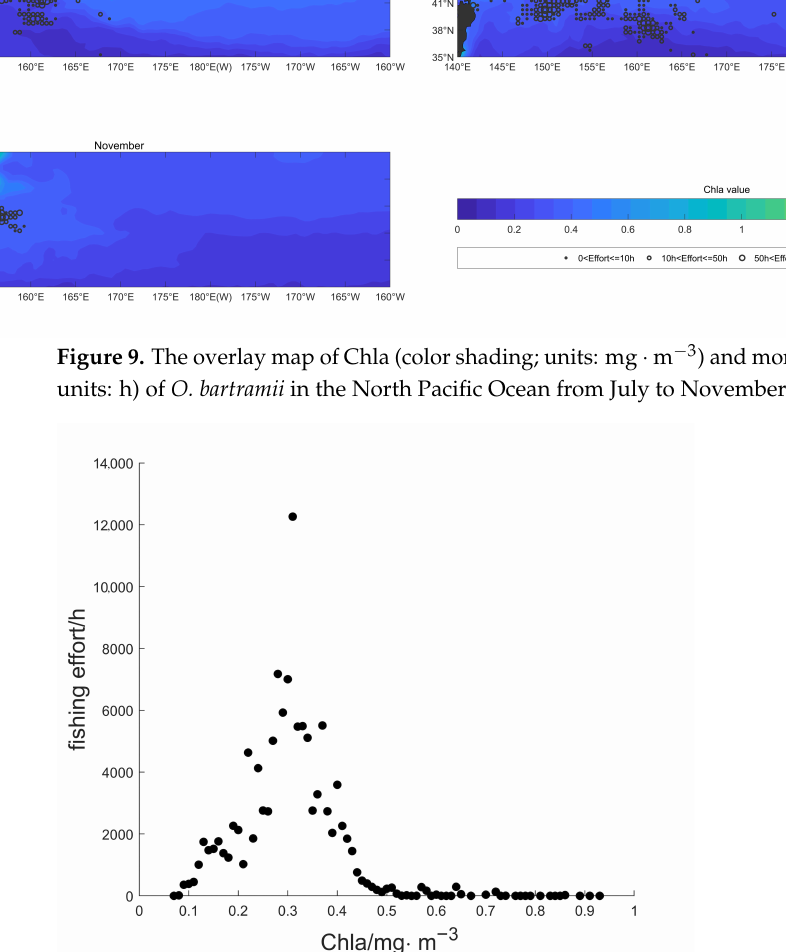
Figure 10. Scatter plot for the relationship between fishing effort and